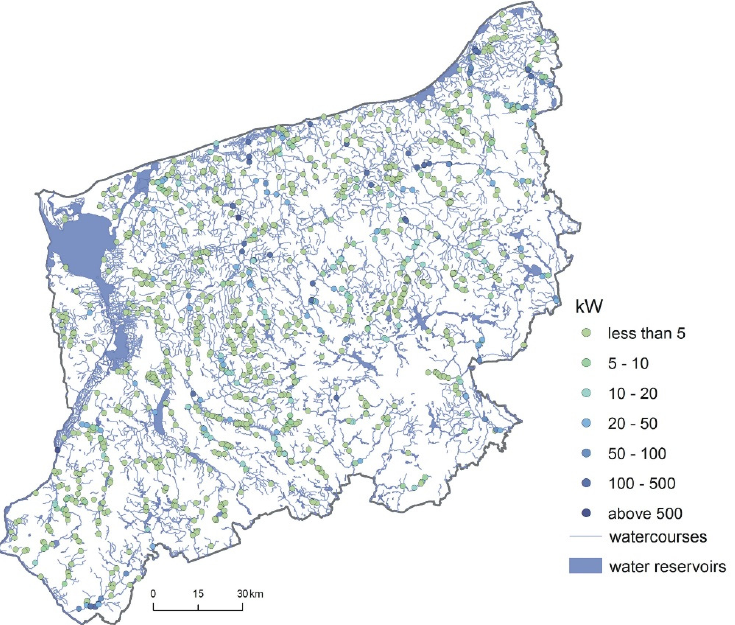
Figure 21. Localization of water dams and power of the potential hydropower plants in the Zachodniopomorskie voivodeship (own